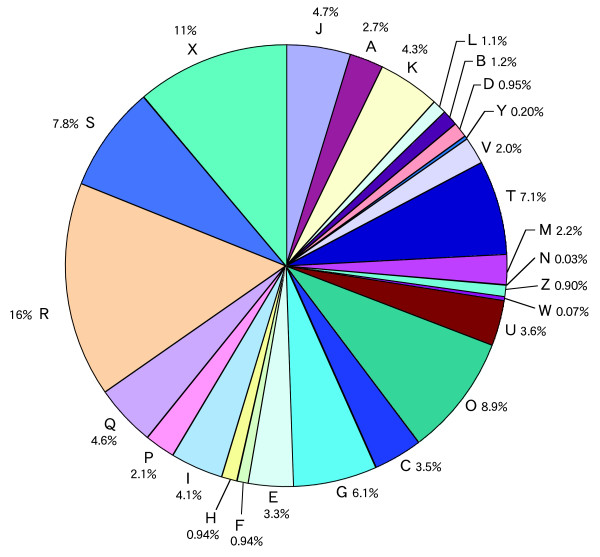
Functional classification and relative levels, as percentages of unique transcripts in the pool, of ESTs derived from male strobili of C. japonica. We assigned 7,369 clusters by reference to databases of KOGs, TWOGs and LSEs using a BLAST-based algorithm (E-value ≤ 10-5). Designations of functional categories: A, RNA processing and modification; B, chromatin structure and dynamics; C, energy production and conversion; D, cell cycle control and mitosis; E, amino acid transport and metabolism; F, nucleotide transport and metabolism; G, carbohydrate transport and metabolism; H, coenzyme transport and metabolism; I, lipid transport and metabolism; J, translation, ribosomal structure and biogenesis; K, transcription; L, replication and repair; M, cell wall/membrane/envelope biogenesis; N, cell motility; O, post-translational modification, protein turnover and chaperone functions; P, inorganic ion transport and metabolism; Q, secondary metabolites biosynthesis, transport and catabolism; T, signal transduction; U, intracellular trafficking, secretion, and vesicular transport; V, defense mechanisms; Y, nuclear structure; Z, cytoskeleton; R, prediction of general function only; S, function unknown; and X, unassigned.